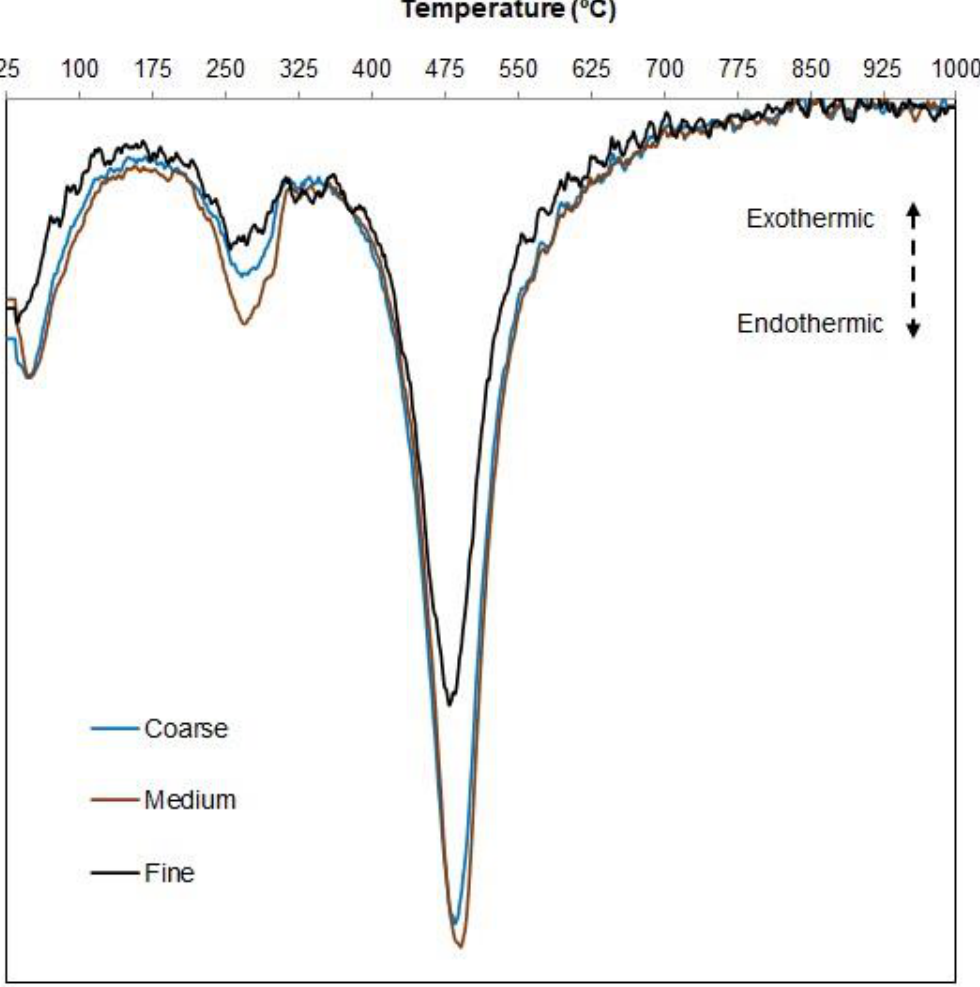
Figure 2. DTA for the three particle-size fractions of lithological material.